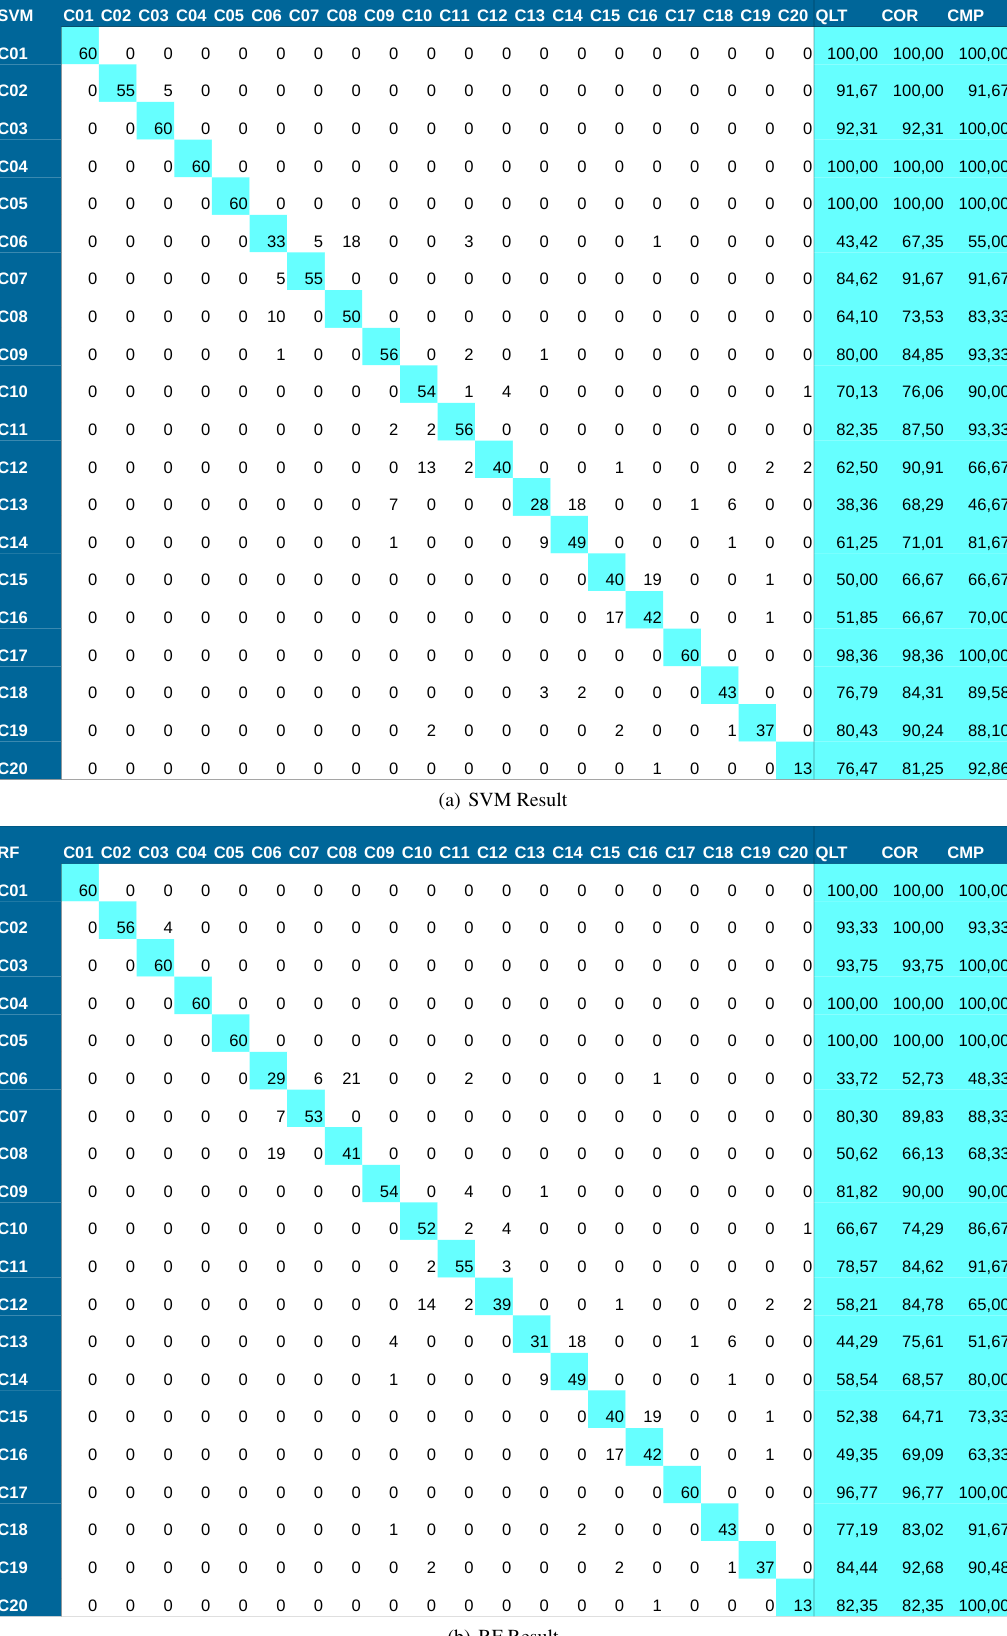
This contribution has been peer-reviewed. Editors: U. Stilla, F. Rottensteiner, and S.